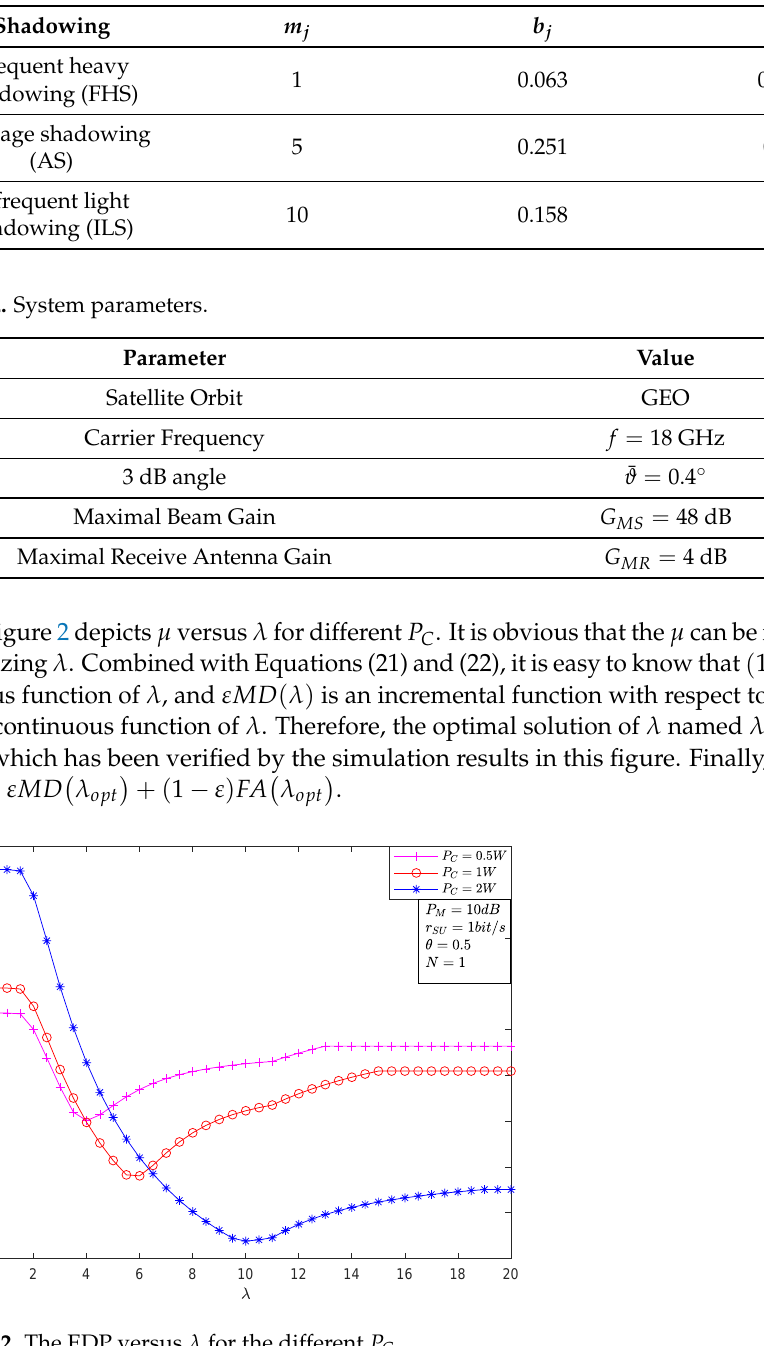
Figure 2. The EDP versus λ for the different P C